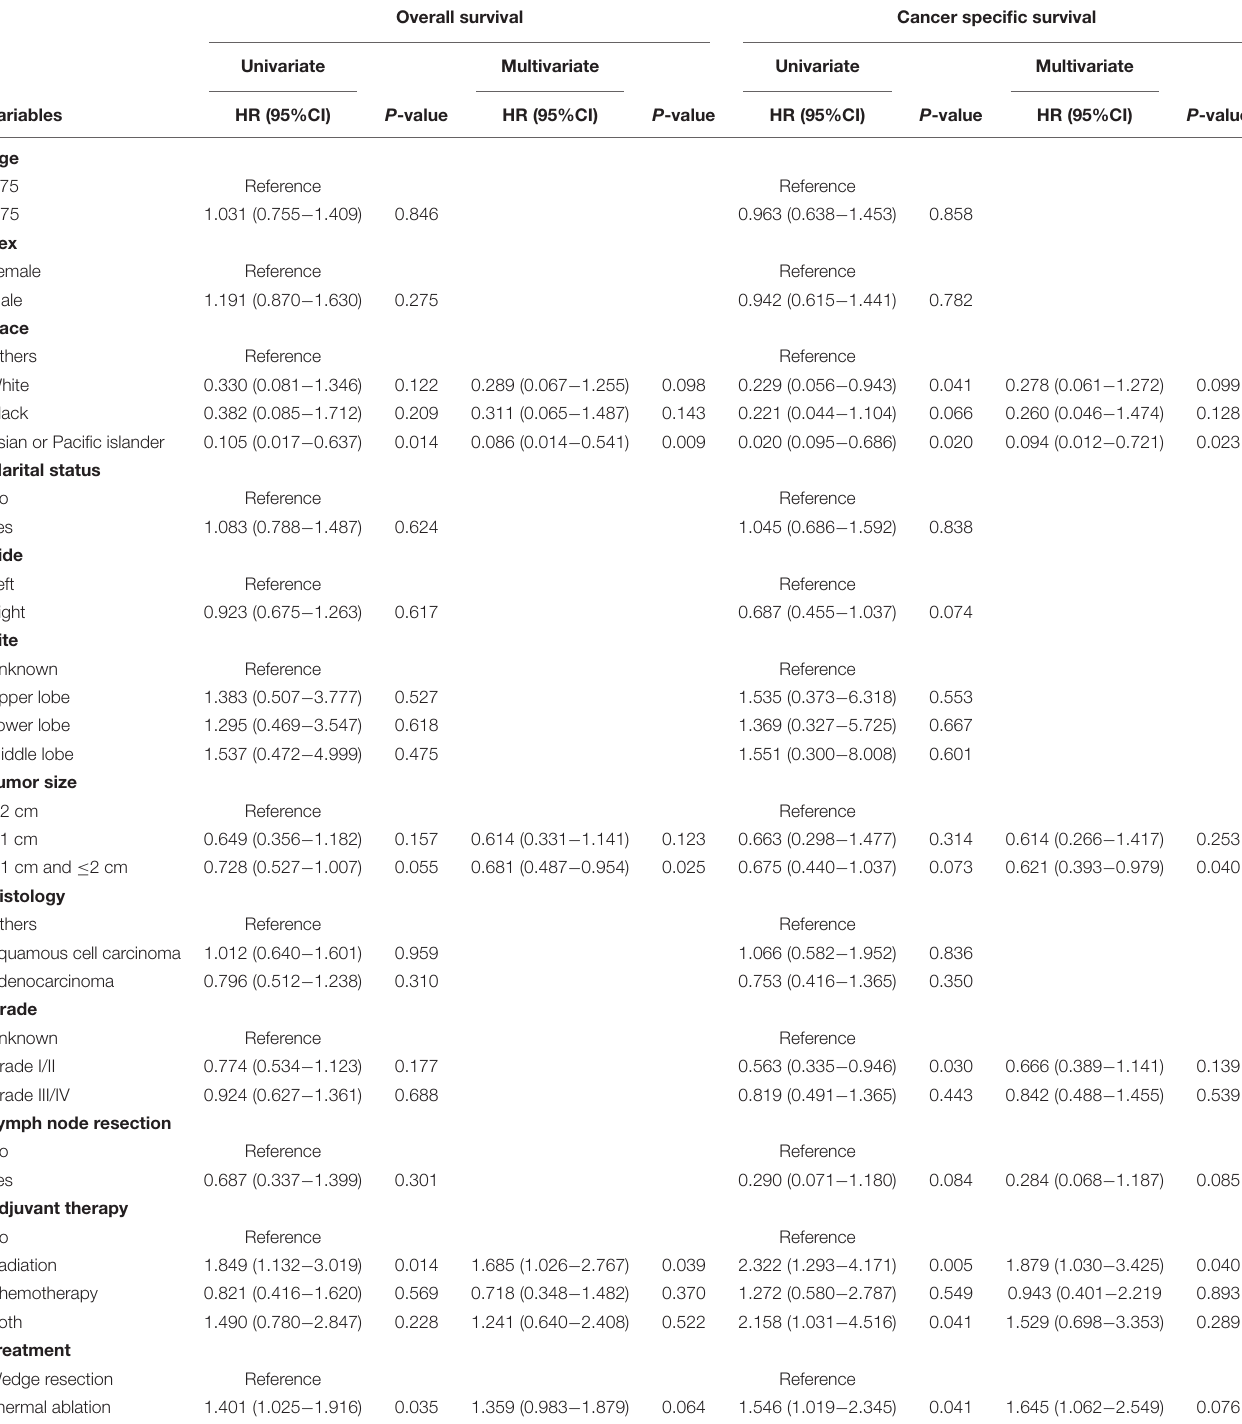
TABLE 3 | Univariate and multivariate Cox regression of OS and CSS in stage I NSCLC patients having thermal ablation and wedge resection after PSM. Overall survival Cancer specific